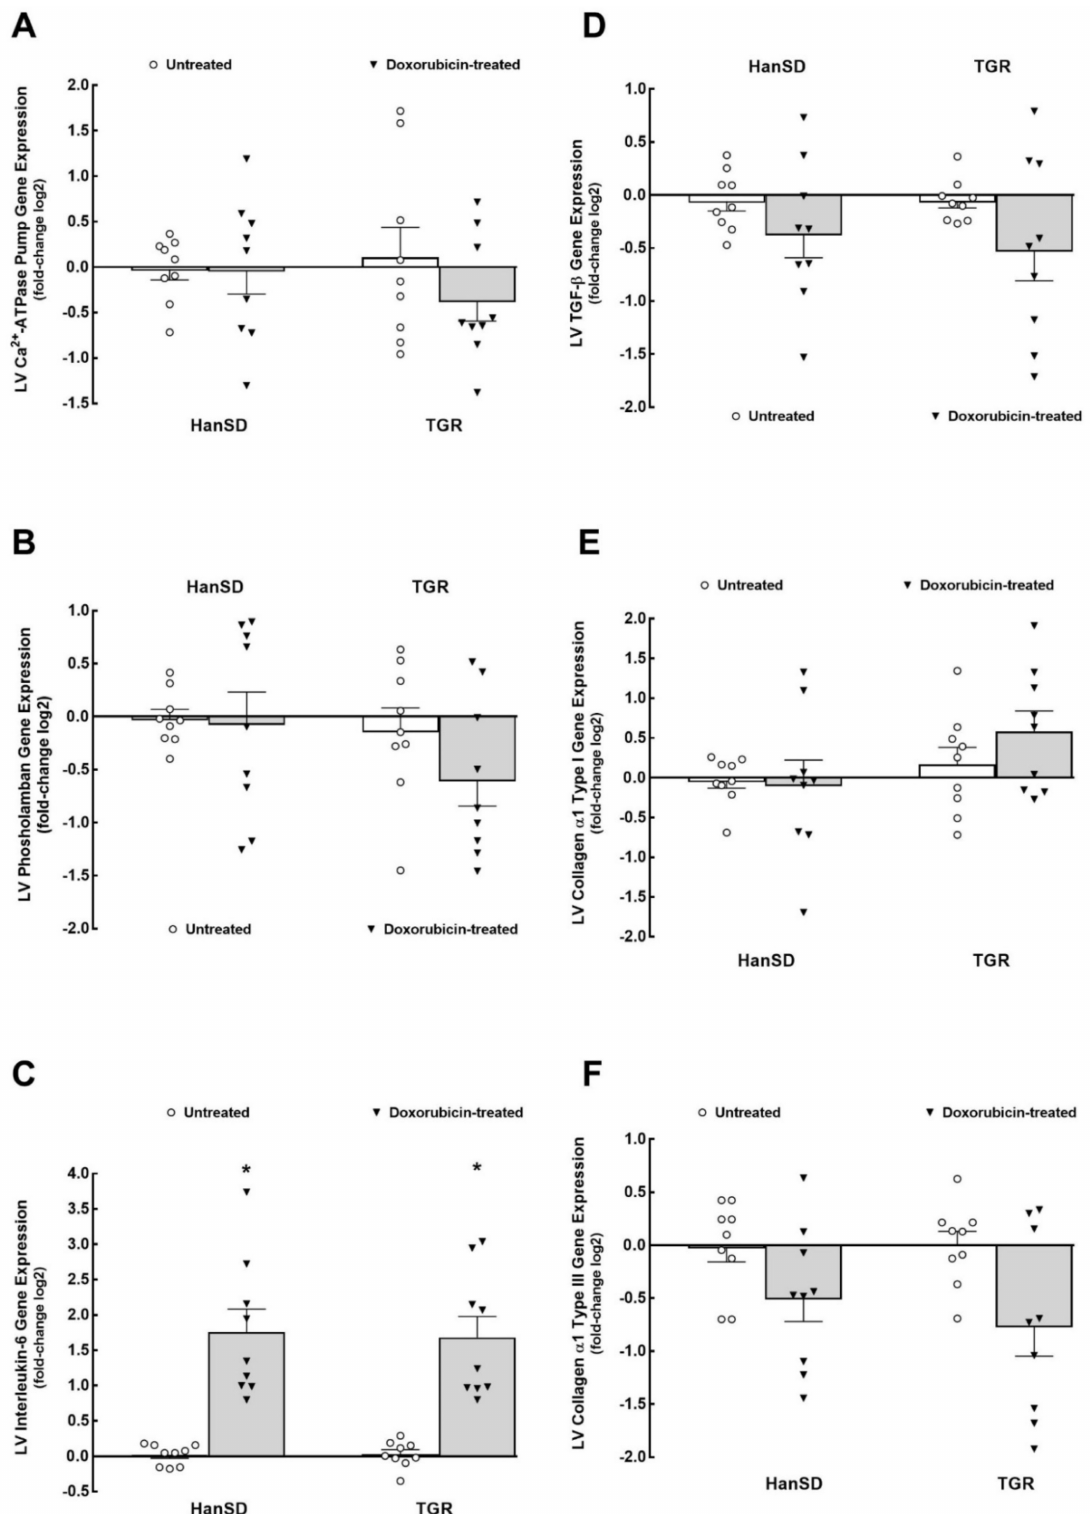
Figure 3. The second part of the left ventricle (LV) mRNA expression. LV Ca 2+ -ATPase pump ( A ), phosholamban ( B ), interleukin-6 ( C ), transforming growth factor beta ( TGF- β ) ( D ), collagen α 1 type I ( E ) and collagen α 1 type III ( F ) gene expression in untreated and doxorubicin-treated normotensive, transgene-negative Hannover Sprague–Dawley (HanSD) and hypertensive, Ren-2 transgenic (TGR) rats. * p < 0.05 compared with untreated animals of the same strain. Statistical comparison was made by one-way ANOVA